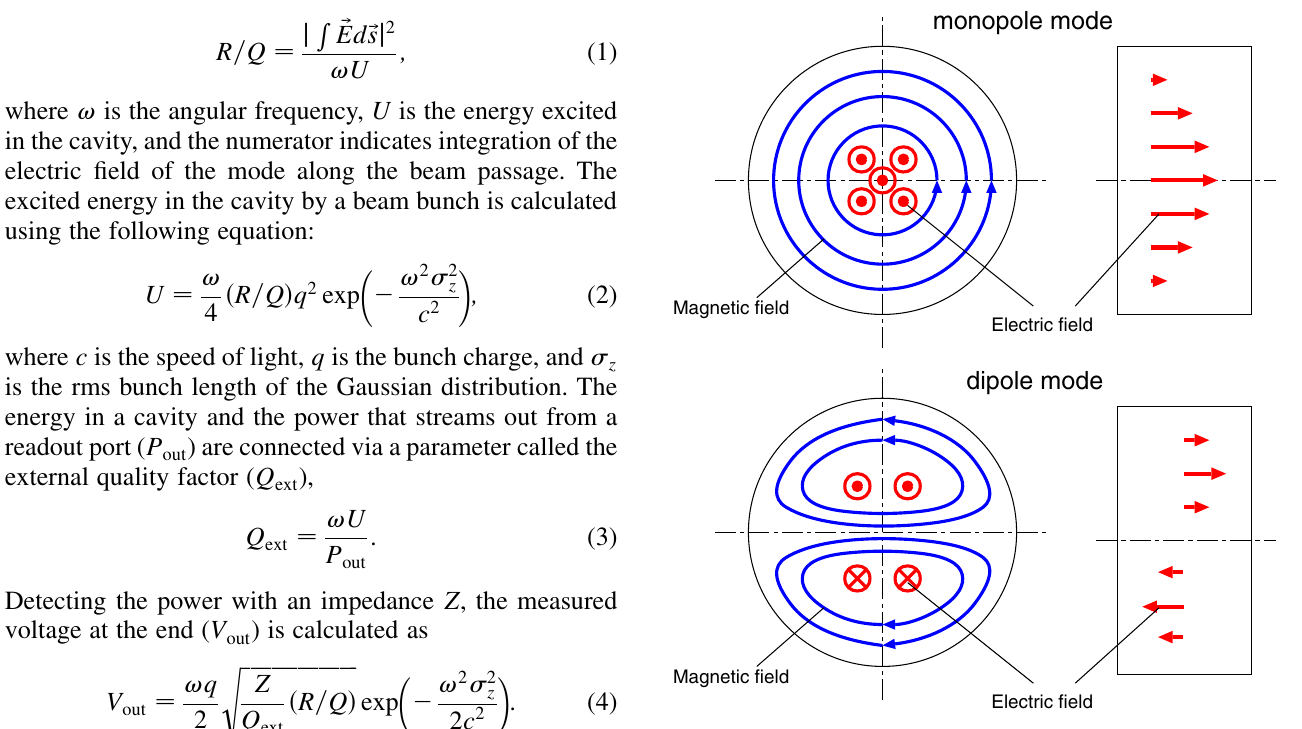
FIG. 1. (Color) First two eigenmodes, TM (dipole mode), of a cylindrical and TM 110